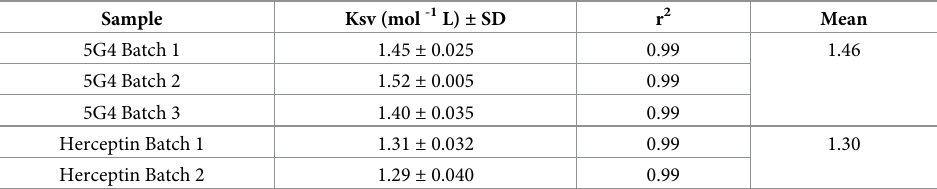
Table 3. Stern-Volmer constant values (Ksv) for 5G4 mAb and Herceptin.